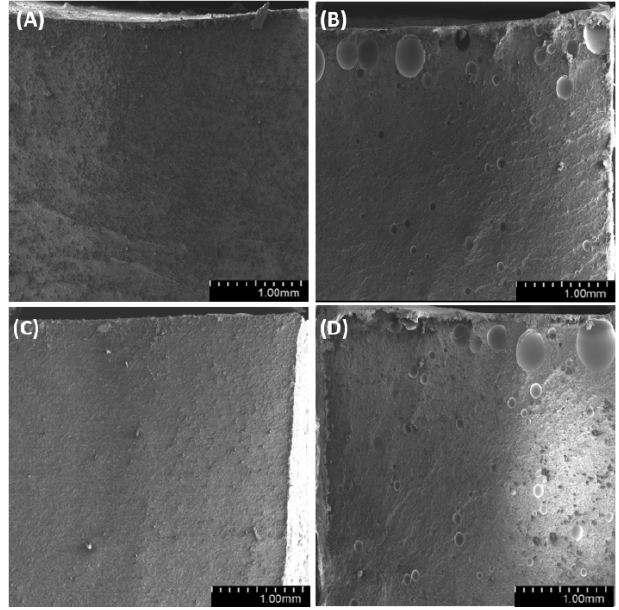
Figure 24. SEM images of the fractures of samples with 70% vol. of diatoms: ( A )—base deg, ( B )—base no deg, ( C )—fractionated deg, ( D )—fractionated no deg.